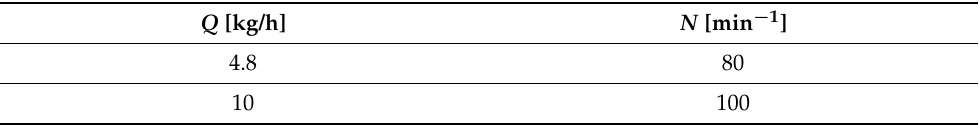
Figure A1. Screw configuration and barrel temperatures of twin-screw extruder. The arrow indicates the flow direction. Names of the screw elements are as defined in the catalog of SHIBAURA MACHINE CO., LTD. Table A1. The flow rate Q and the screw rotation speed N of the twin-screw extruder in the